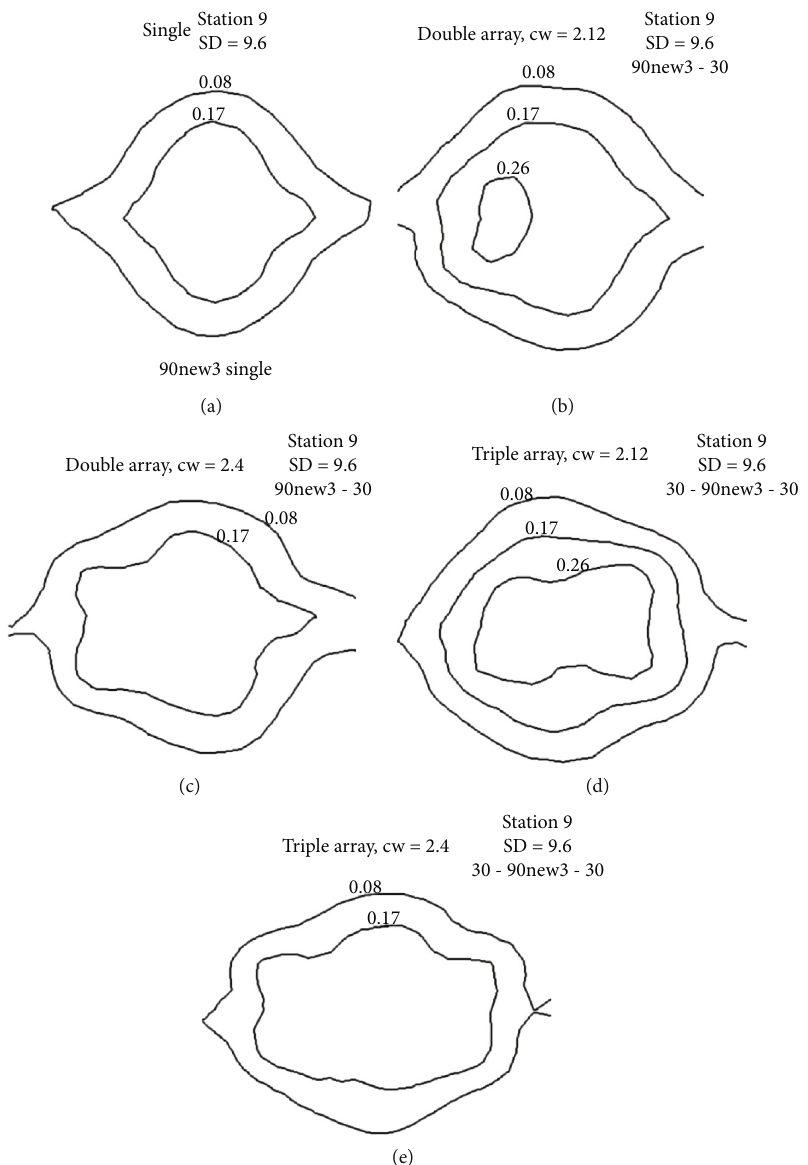
Figure 16: Illustration of the hierarchical process hypothesis in loss distribution from a single pattern to triple wedges